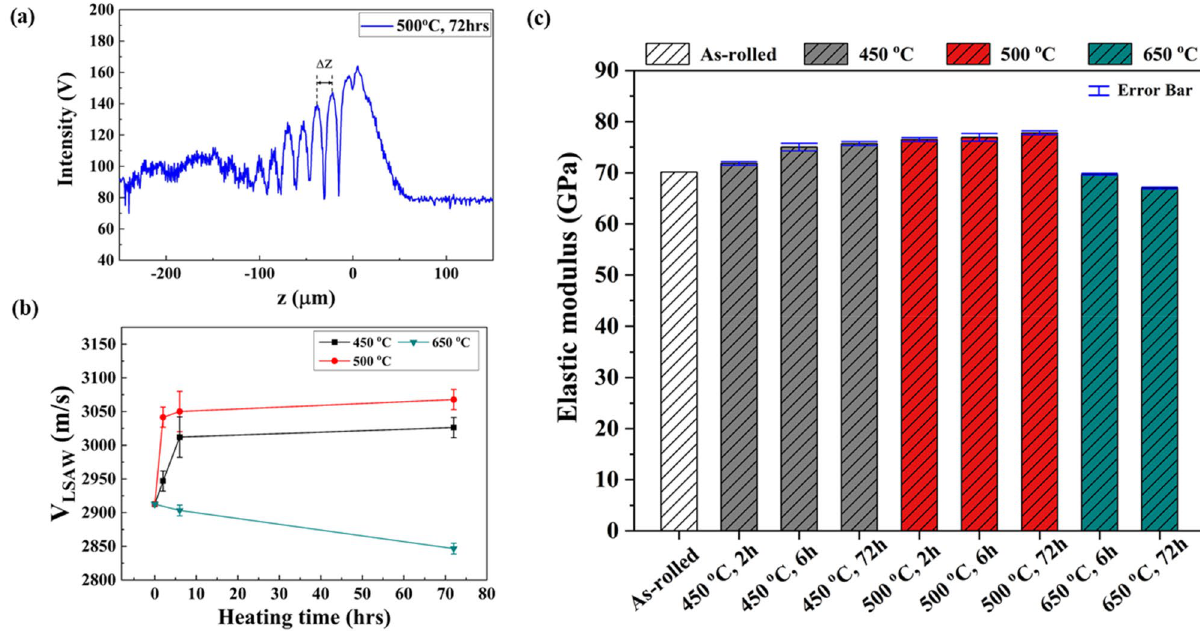
Figure 7. ( a ) V(z) curve for Al-C composite specimen heat-treated at 500 ℃ for 72 h, ( b ) Leaky surface acoustic wave velocity, v LSAW , for Al-C composite specimens as functions of heat treatment time and temperature, and ( c ) variation of elastic modulus for Al-C composite specimens as functions of heat treatment time (h) and